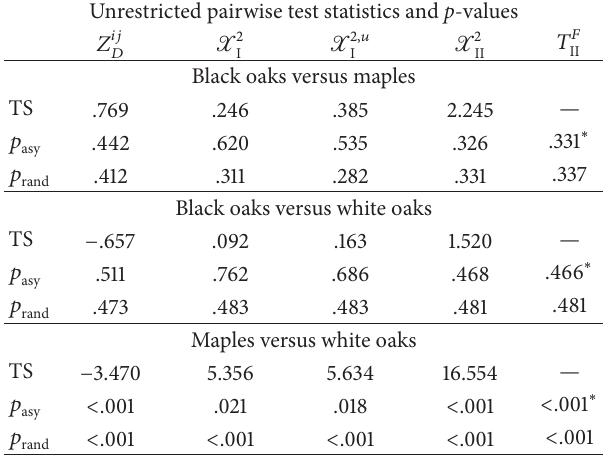
Table 16: The test statistics and the p -values for the unrestricted pairwise symmetry analysis for the Lansing Woods data. Row labelings and the asterisks are in Table